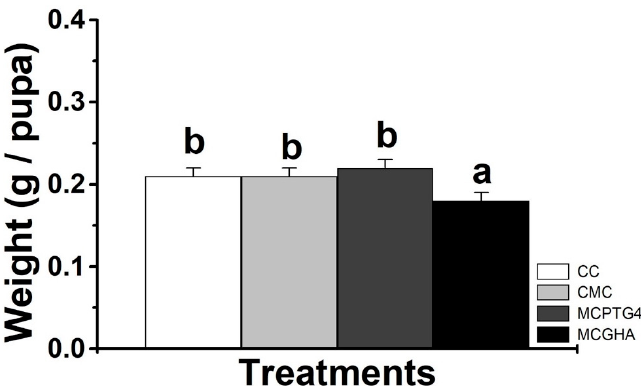
Figure 3. S. frugiperda pupal weight after feeding on the plants from the specified treatments. CC: Negative control, CMC: Negative control with only methylcellulose, MCPTG4: B. bassiana fungal strain PTG4 with methylcellulose, MCGHA: B. bassiana fungal strain GHA with methylcellulose. Analysis done with Duncan’s post-hoc multiple range test ( α = 0.05) after one-way ANOVA. Graphical bars with the same letters indicate that there were no significant differences among them.